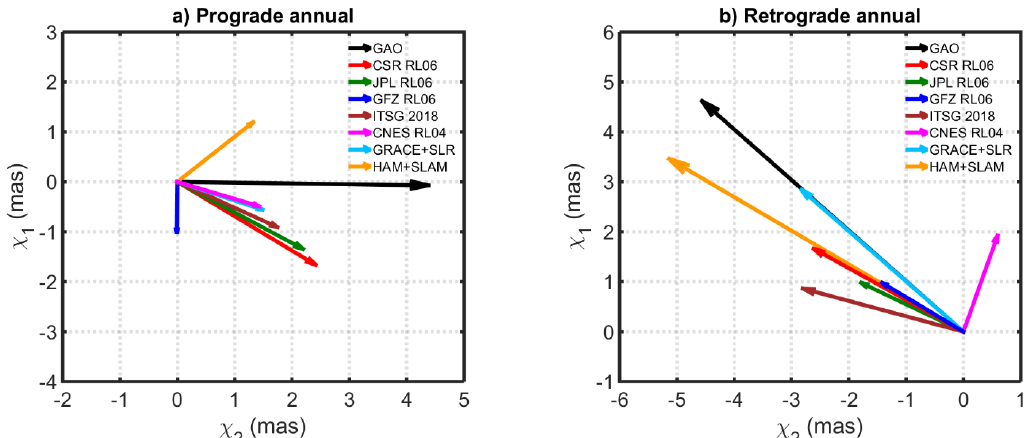
Figure 8. Phasor diagrams of prograde and retrograde annual variation in χ 1 + iχ 2 for GAO, GSMAM, GRACE + SLR, and HAM + SLAM. Phase φ of the oscillation is defined by the annual term as sin(2π(t − t 0 ) + φ), where t 0 is the reference epoch (1 January 2004).